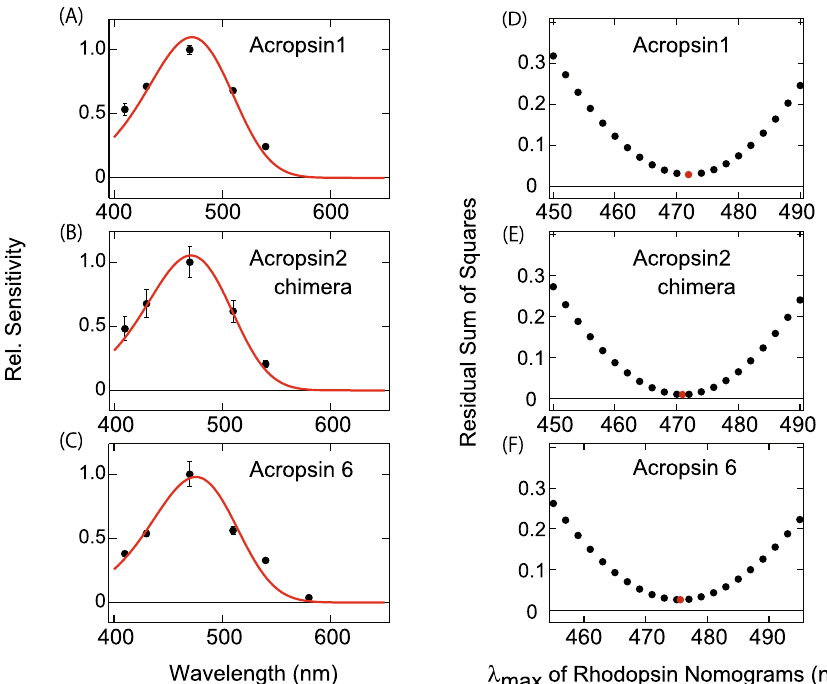
Figure 3. Estimation of the spectral sensitivity curves for acropsins 1, 2 and 6. The spectral sensitivities of ( A ) WT acropsin 1, ( B ) acropsin 2 chimera mutant having the third cytoplasmic loop of the box jellyfish opsin, and ( C ) WT acropsin 6. Black circles represent the mean (n = 3 in A – C ) relative sensitivities (change in luminescence/cAMP) of cultured cells expressing each acropsin at each wavelength of light. Error bars represent standard errors. The spectral sensitivities were fit with the estimated sensitivity curves (Govardovskii templates) with λmax of ( A ) 472 nm, ( B ) 471 nm, and ( C ) 476 nm, respectively (shown as red curves). ( D – E ) The values of residual sum of squares (RSS) are shown to assess the goodness of fit between experimentally obtained sensitivities and the sensitivity curves with different λmax values. ( D ) acropsin 1, ( E ) acropsin 2 chimera mutant, and ( F ) acropsin 6. The λmax values of the sensitivity curves for calculating RSS were provided around those of best-fitting curves (shown as red dots) at 2 nm intervals: between 450 and 490 nm for ( D ) and ( E ) or between 455 and 495 nm for ( F ).